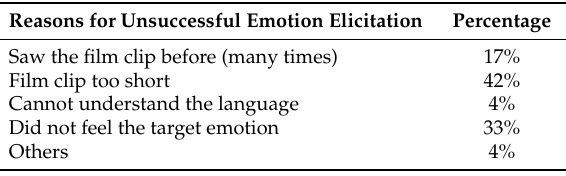
Table 4. Reasons for unsuccessful emotion